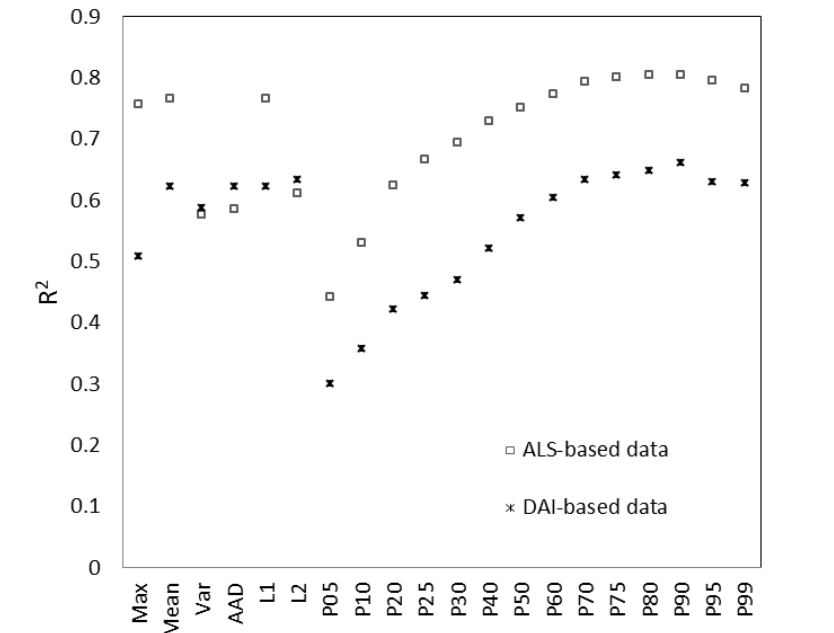
Figure 5. Coefficient of determination (R 2 ) derived from the relationship between tree height and maximum, mean, variance, average absolute deviation (AAD), L-moments (L1, L2), and percentile values (5th, 10th, 20th, 25th, ..., 95th percentiles) derived from the ALS-based and the DAI-based data.